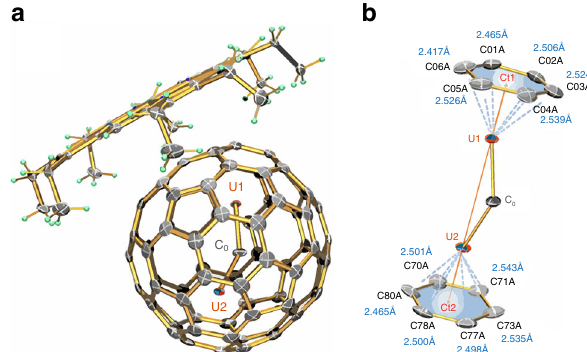
Fig. 1 ORTEP drawing of UCU@ I h (7)-C 80 ·[Ni II -OEP] with 40% probability ellipsoids. a UCU@ I h (7)-C 80 ·[Ni II -OEP] structure showing the